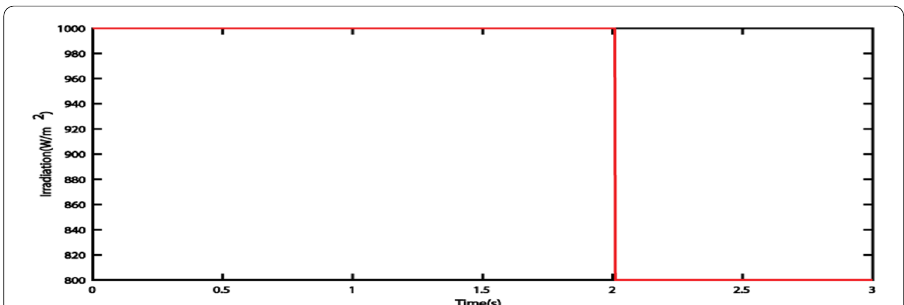
Fig. 12 Solar irradiation scenario with (W/m 2 )